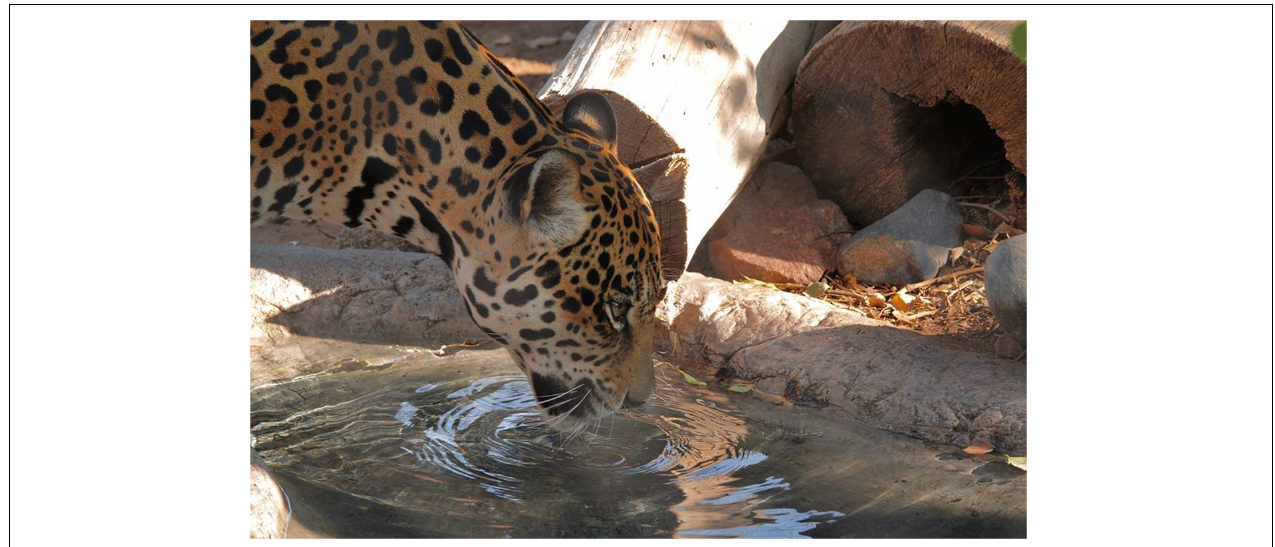
FIGURE 1 | Image of a jaguar drinking at the Phoenix Zoo, AZ, United States. Photo credit: David Bissegger.